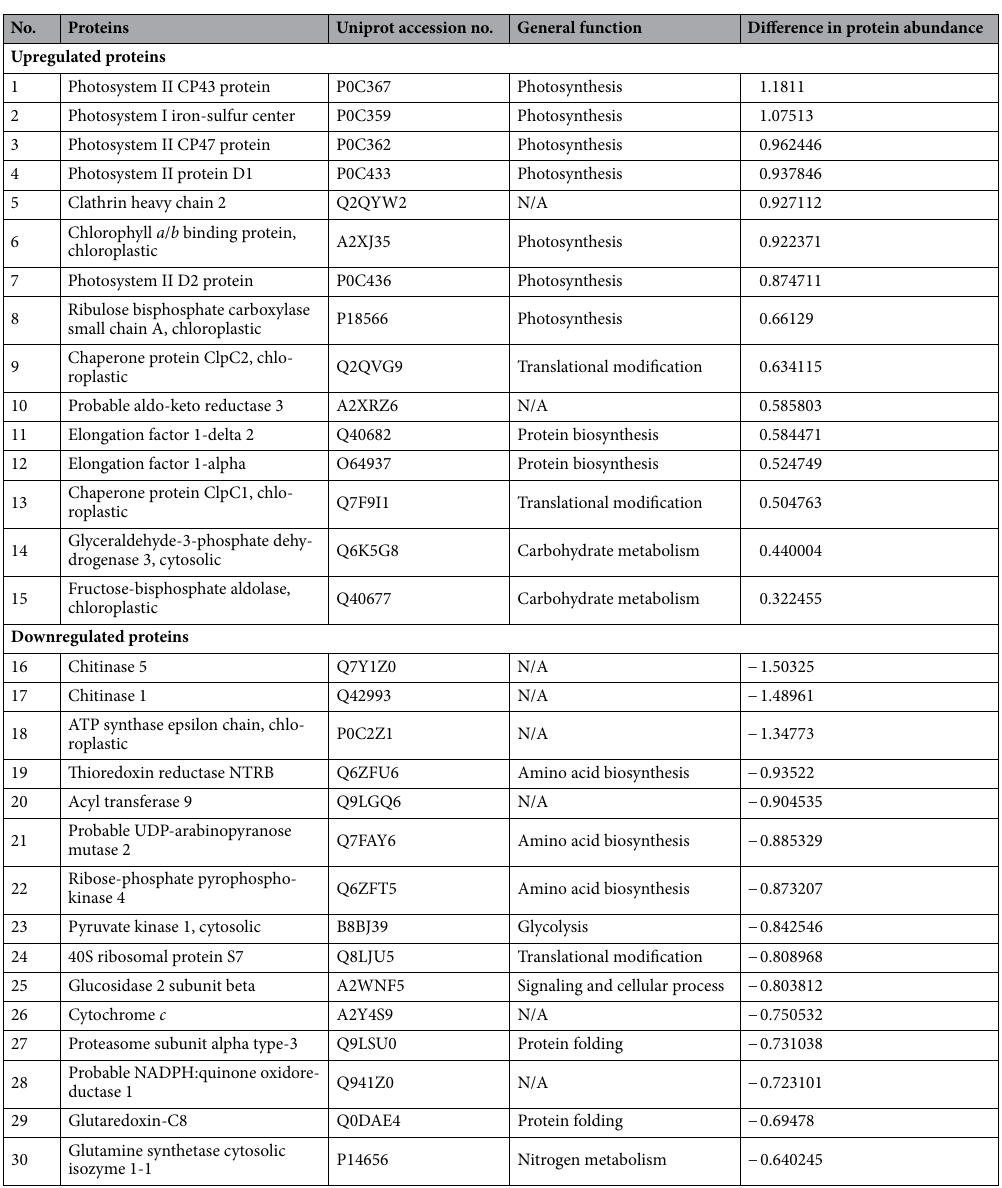
Table 1. Top 15 up- and down-regulated proteins of significant difference in NaLS-treated rice. N/A not